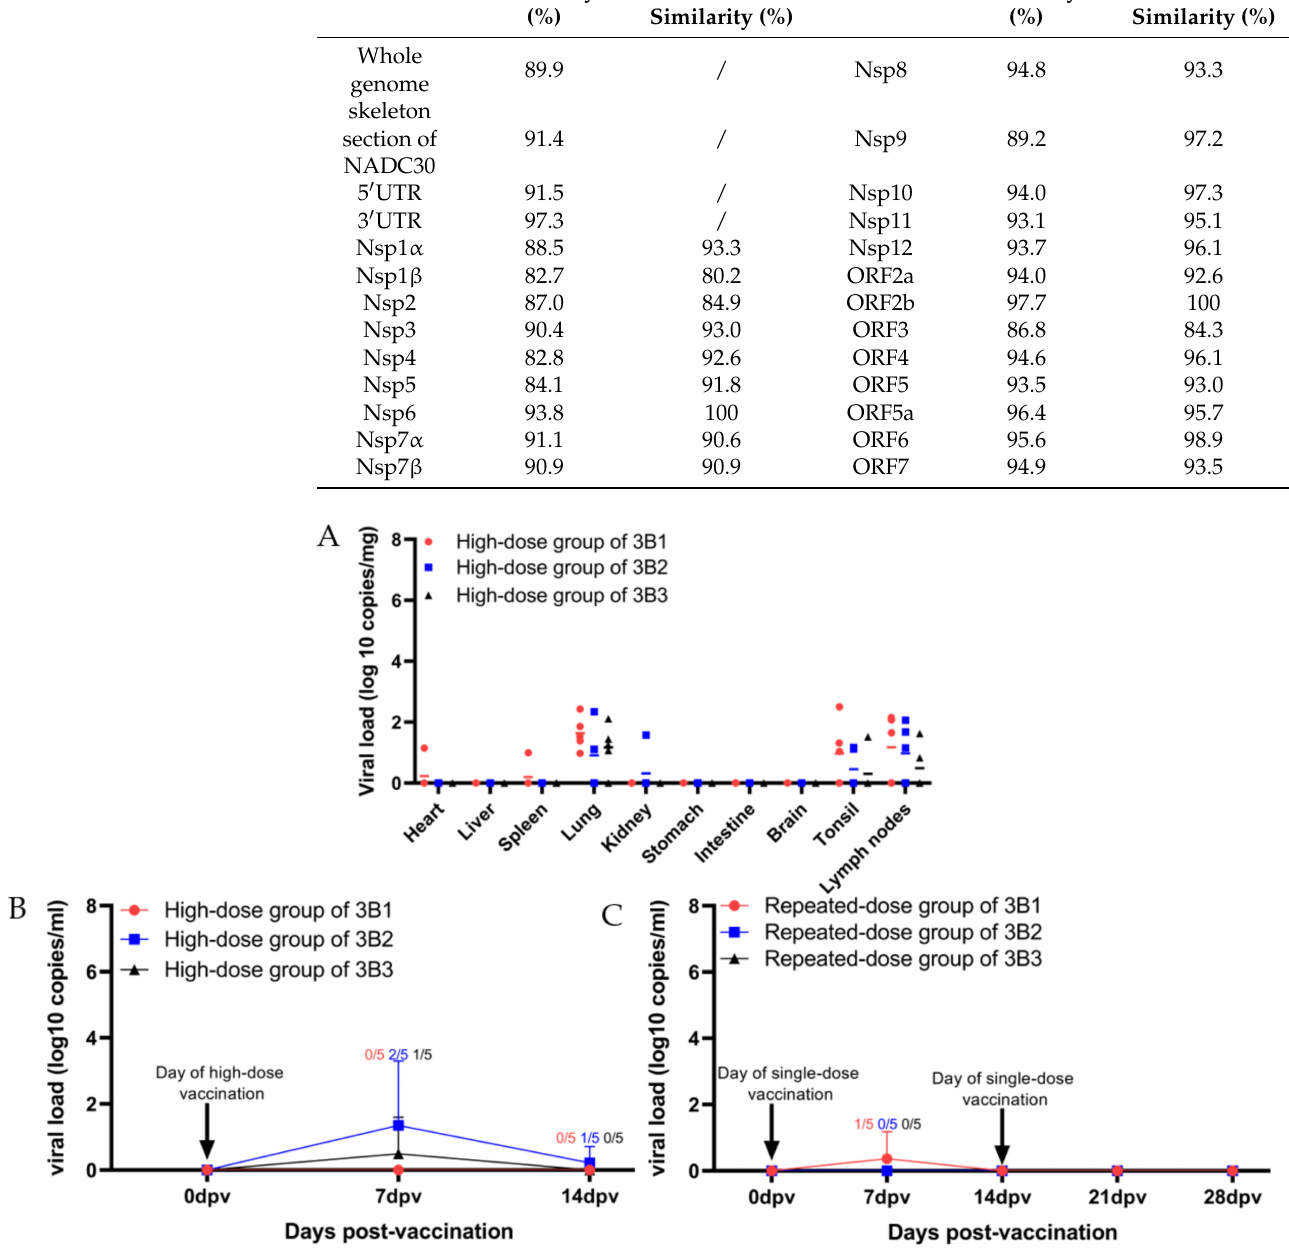
Figure 2. Viral loads in ten tissues or sera of high-dose groups ( A ) and ( B ) and repeated-dose ( C ) groups. PRRSV viral RNA in sera and tissues was measured by qPCR. High-dose groups and repeated-dose groups of three batches of laboratory products of SD-R were labeled with a red circle ( • ), blue box ( (cid:4) ), and black triangle ( (cid:78)